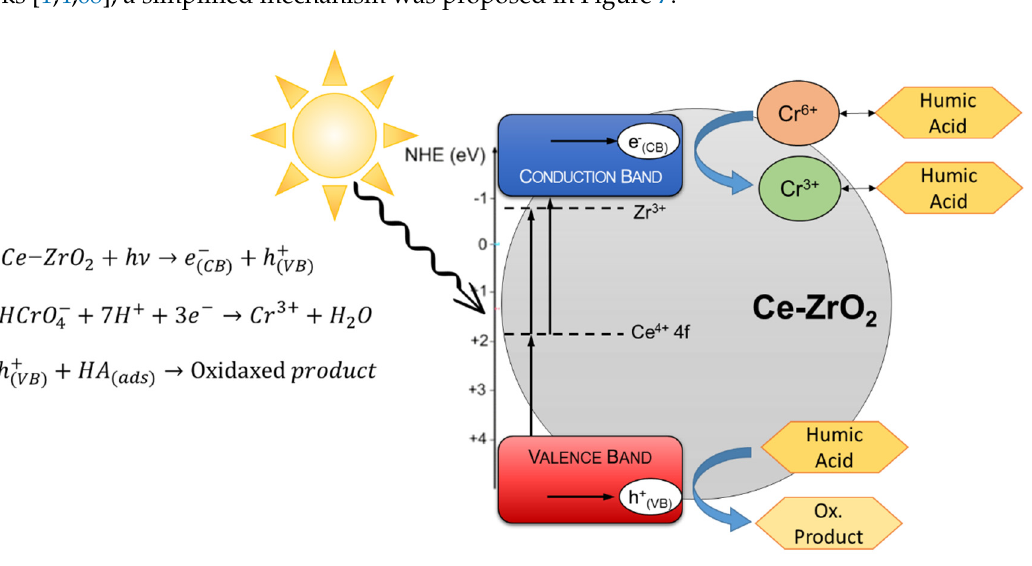
Figure 7. Proposed mechanism for the photocatalytic reduction of Cr(VI) in the presence of HA using Ce–ZrO 2 under visible light irradiation.